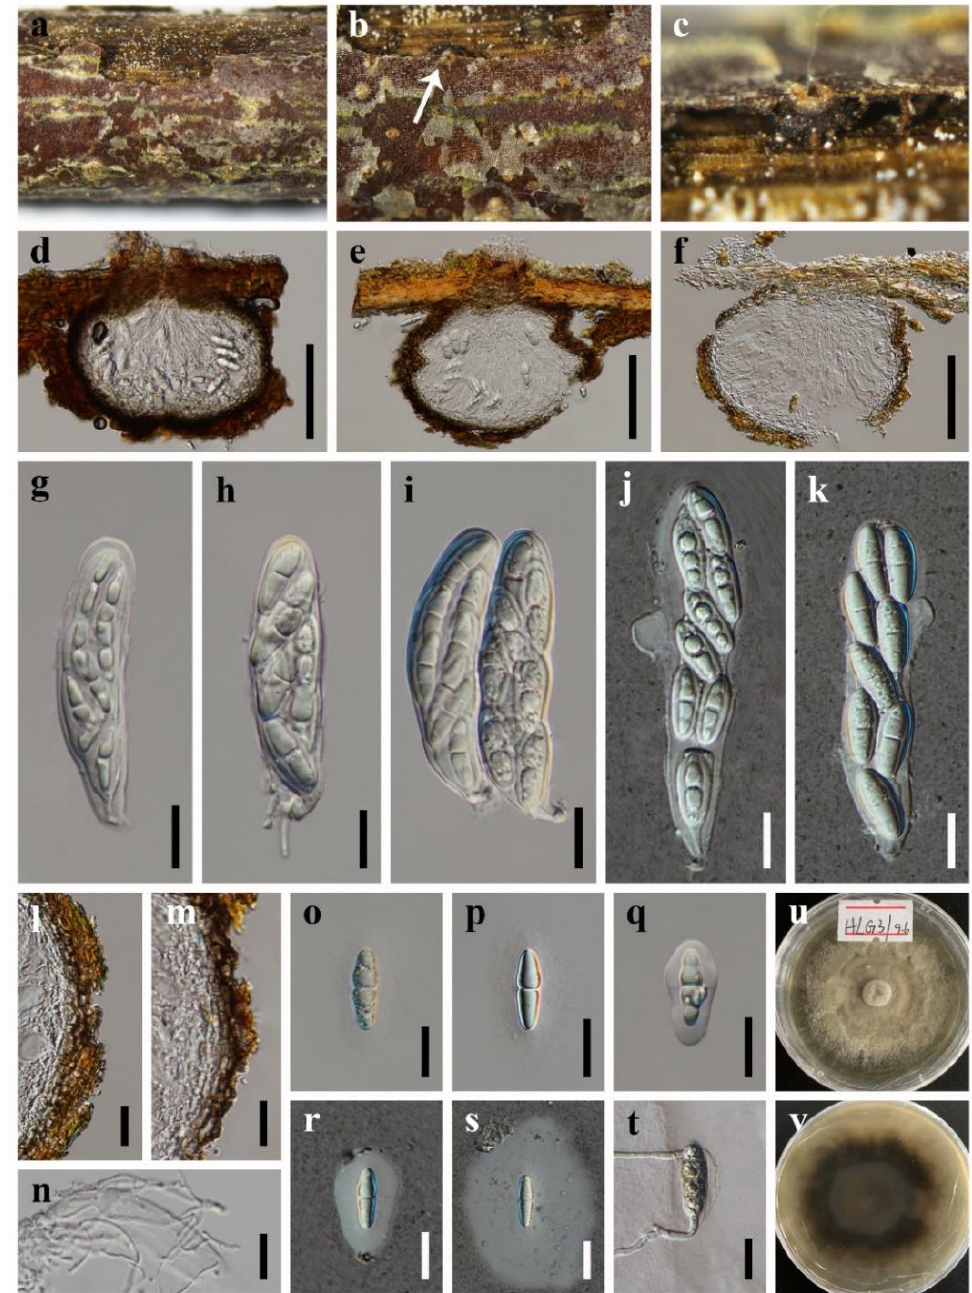
Figure 2. Neoangustimassarina sichuanensis (HKAS 123092, holotype ) ( a – c ) Ascomata on host sub- strate. ( d – f ) Vertical section of ascoma. ( g – k ) Asci. ( l , m ) Structure of peridium. ( n ) Pseudoparaphyses. ( o – s ) Ascospores. ( t ) Germinated ascospore. ( u , v ) Colonies on PDA, above ( u ) and below ( v ). Scale bars: ( d – f ) = 100 μm, ( g – t ) = 20 μm.